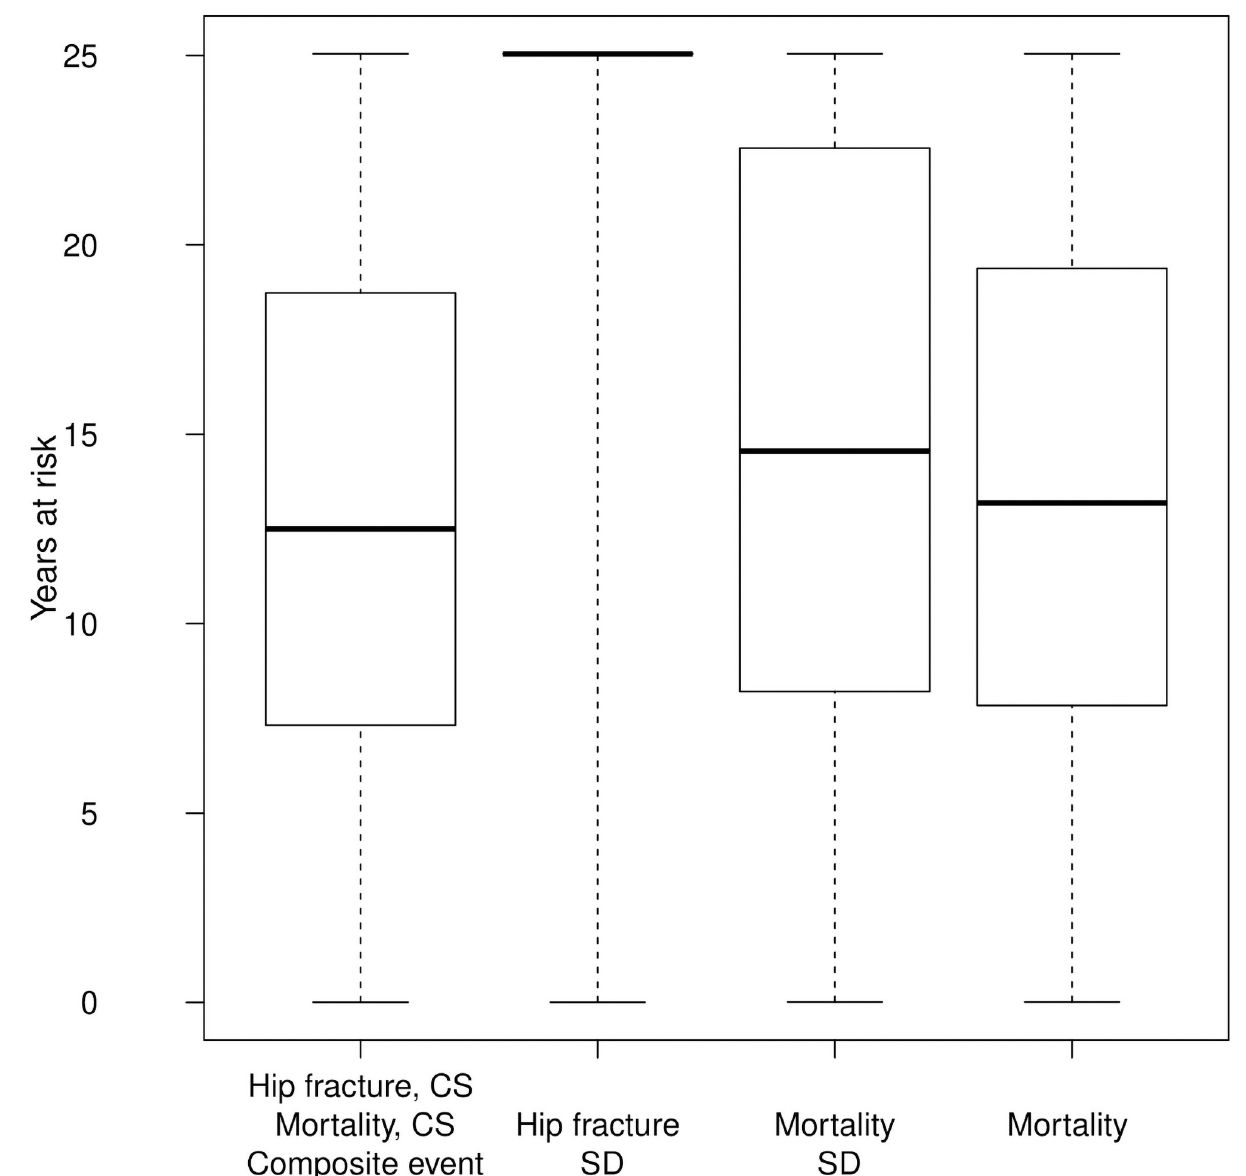
Fig 4. Boxplots of years at risk for incident hip fracture and mortality. Various